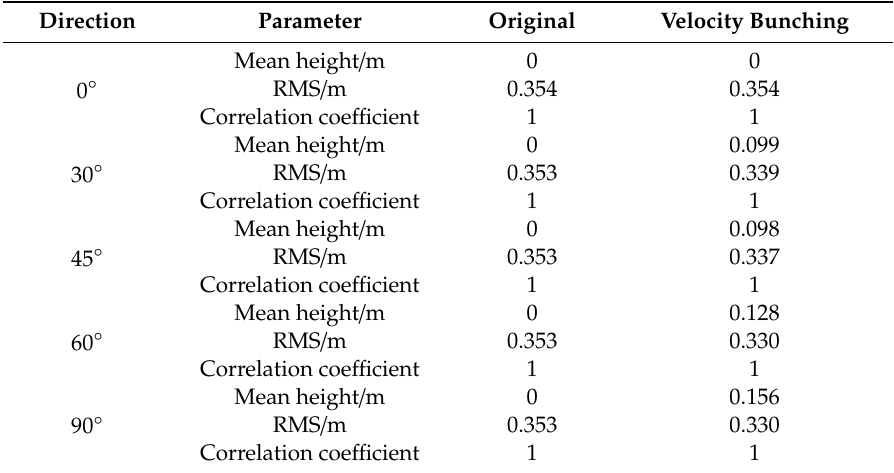
Table 2. The influence of velocity bunching under di ff erent swell propagation directions (the significance wave height (SWH) is 2 m, the wavelength is 200 m).